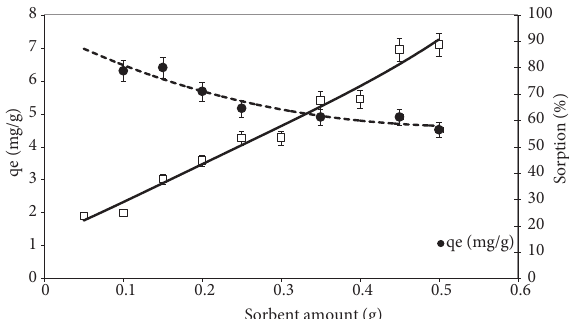
Fig. 6. The effect of sorbent amount on Cu 2+